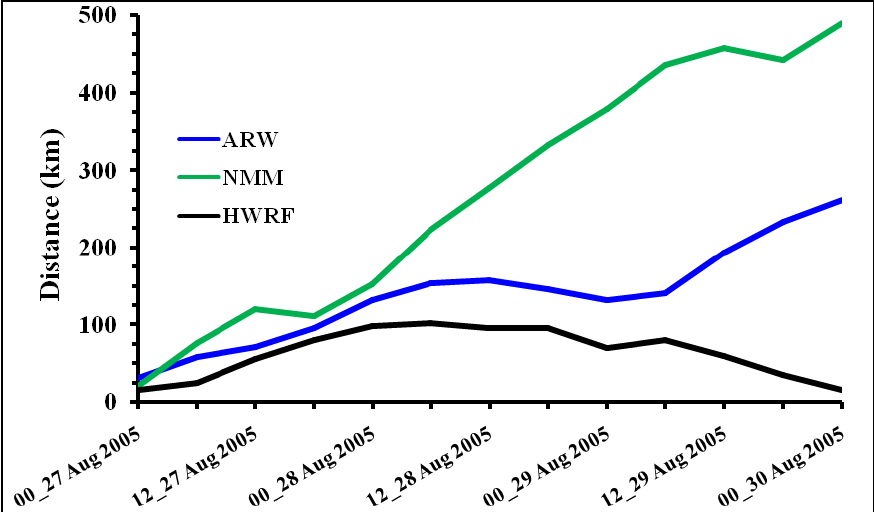
Figure 10. Vector Track Position Errors (km) for the model experiments with ARW, NMM and HWRF